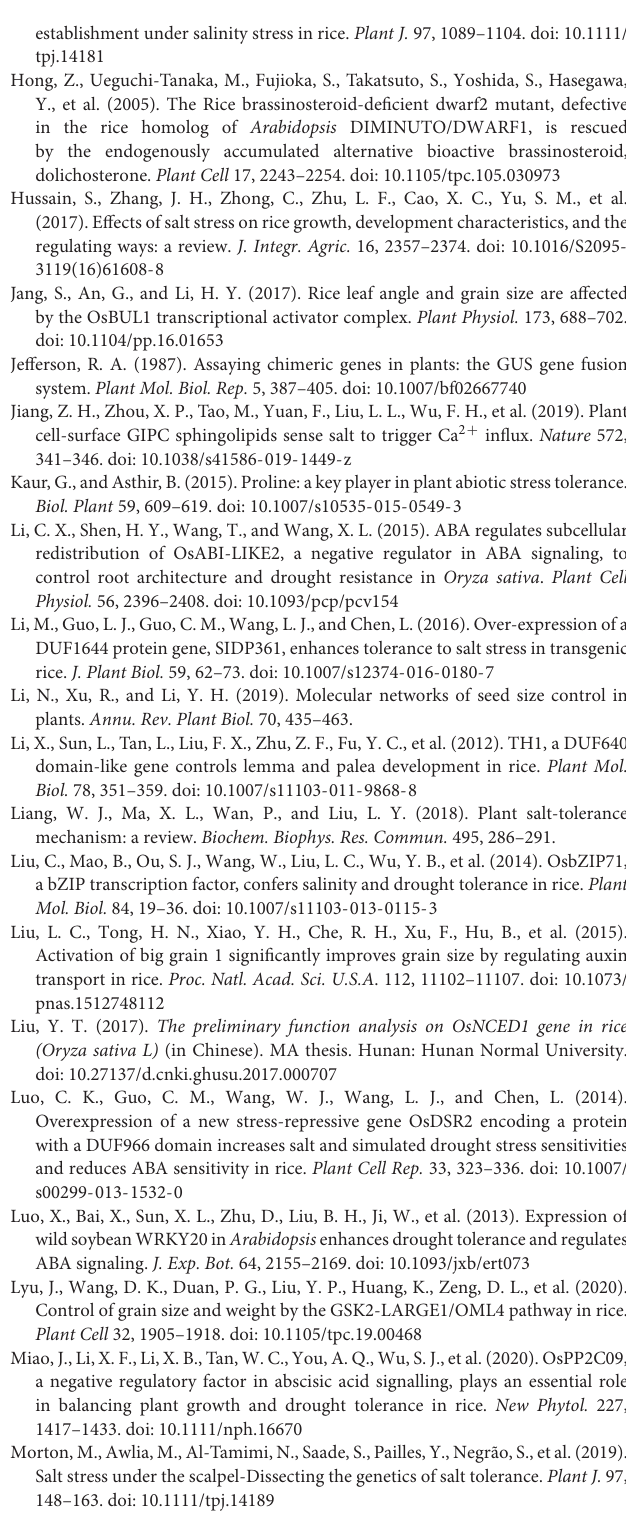
Supplementary Table 2 | Differentially Expressed Genes (DEGs) between WT, OsSIDP301 OE , and OsSIDP301 RNAi from RNA-seq analysis, and using leaves as the material with 150 mM NaCl treatment for 3 days.